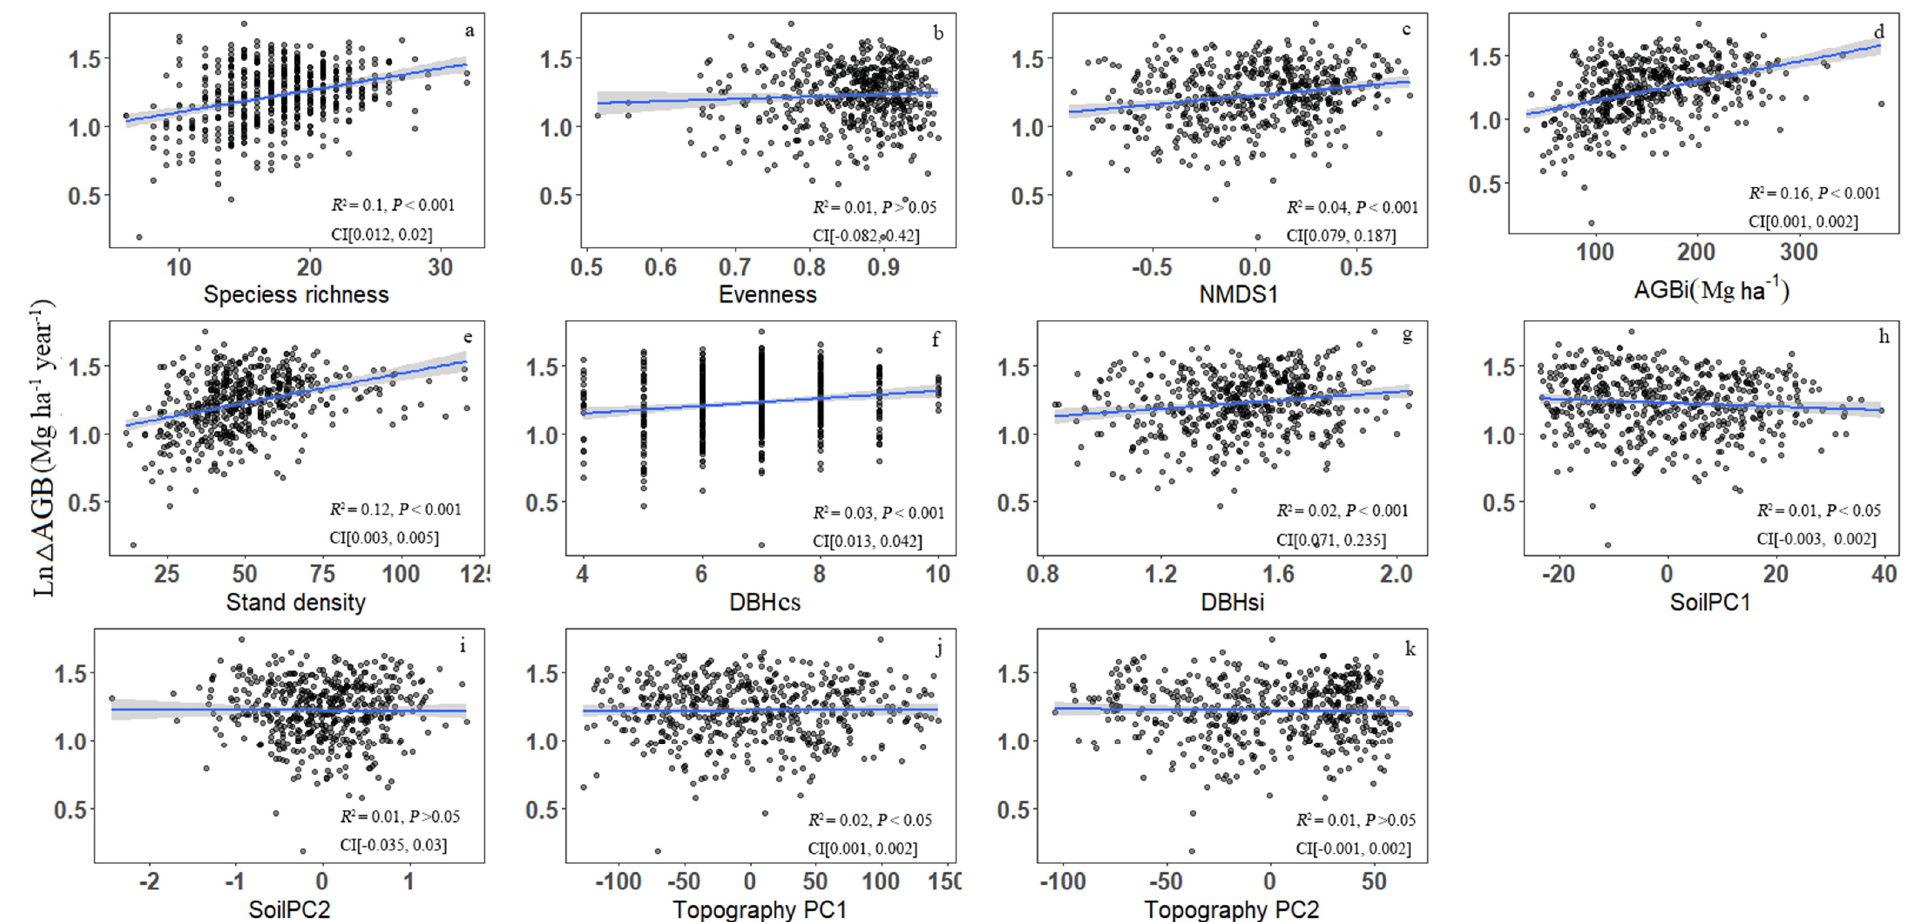
Figure 2. Bivariate relationships between forest productivity (ln-transformed Δ AGB) and species diversity [( a ) species richness, ( b ) evenness], species composition [( c ) NMDS1], initial above-ground biomass [( d ) AGBi], structural factors [( e ) stand density, ( f ) DBH classes (DBHcs), and ( g ) tree size diversity (DBHsi)], environmental factors [( h ) soil PC1, ( i ) soil PC2, ( j ) topography PC1, and ( k ) topography PC2] in Tiantong plot (CI, 95% confidence interval for the regression coefficients).